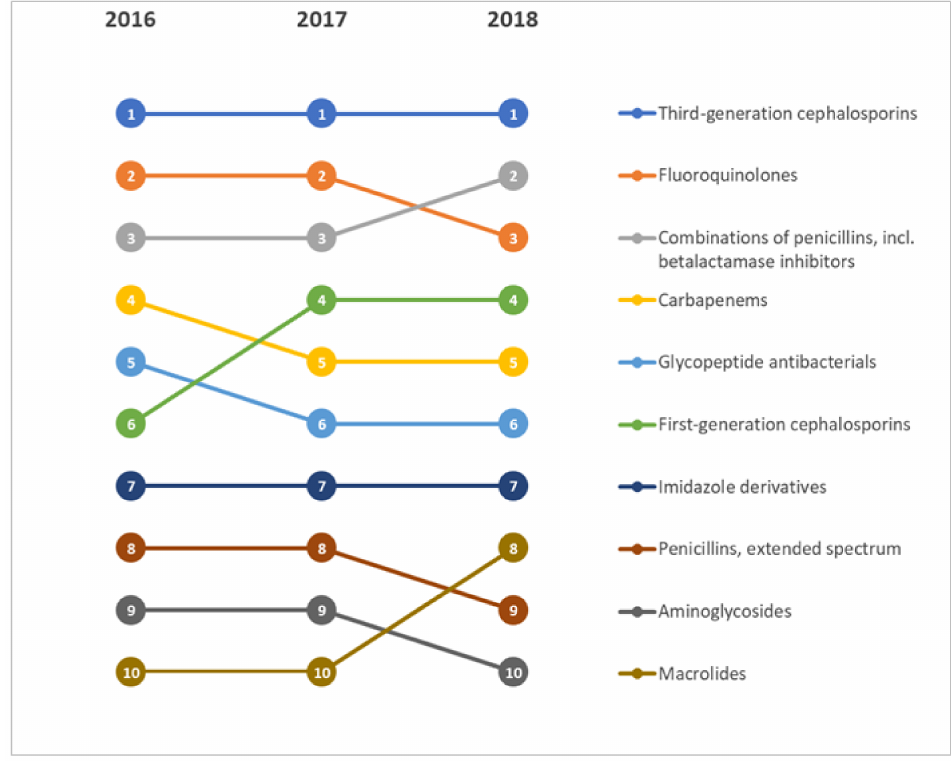
Figure 4. Ranking of antimicrobial agents by year of the Point Prevalence